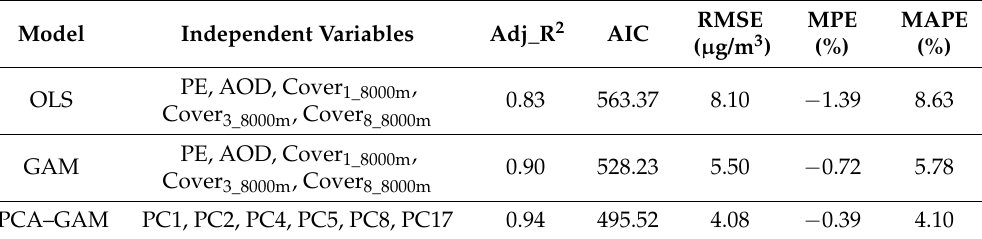
Table 1. The regression results of three models.